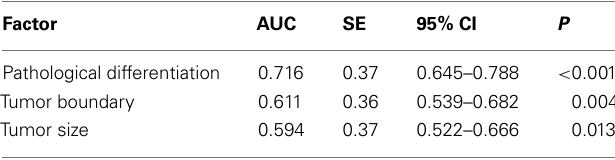
Table 4 |Area under the curve demonstrating the discriminatory power of each factor for predicting LNM.